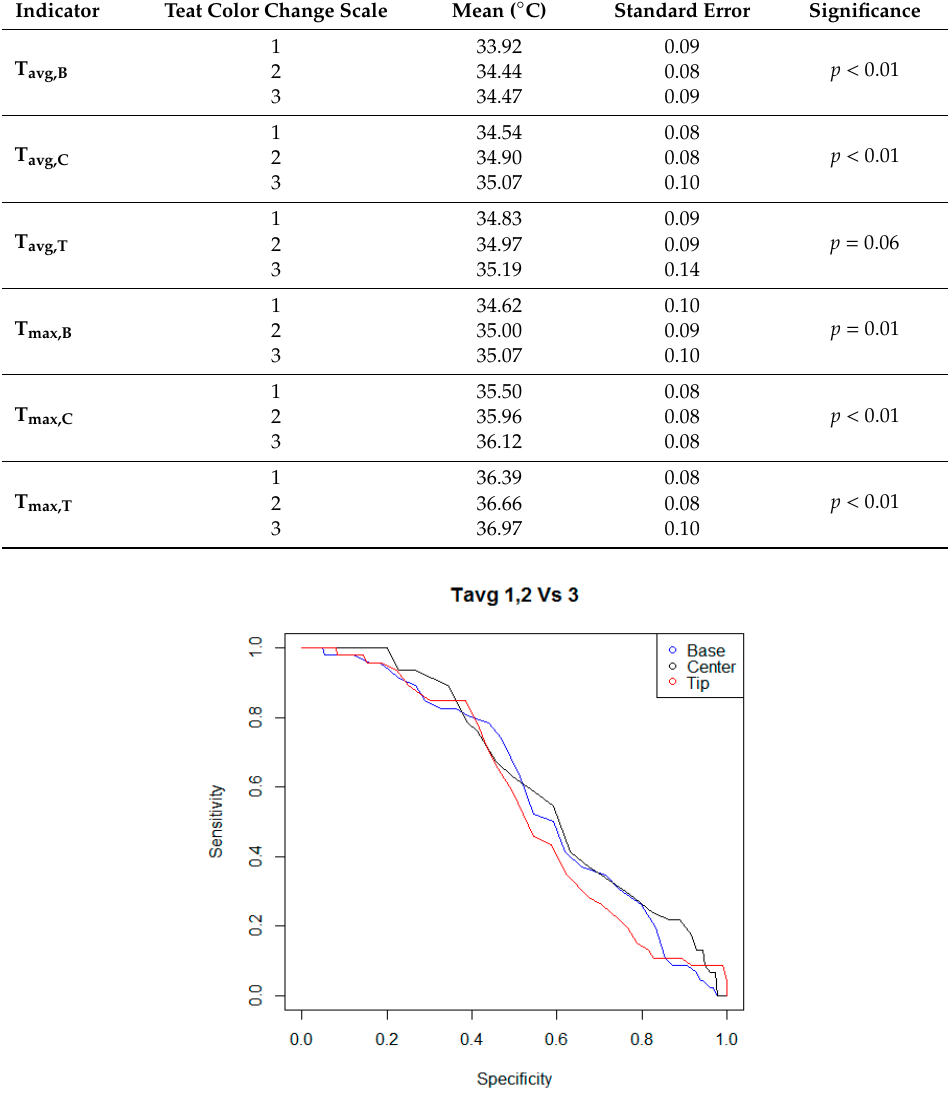
Figure 4. ROC curves of the statistical tests that were built considering the performances of the indicators T avg,B , T avg,C , and T avg,T , and different possible cutoff levels. Teat status was considered as “mechanically stressed” when its scoring fell in the level “two” or “three” of the color change scale adopted.